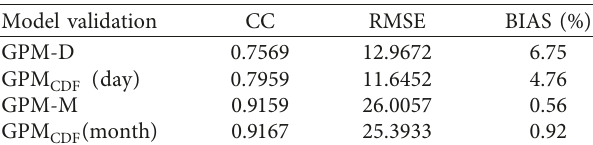
Table 6: CDF model verification